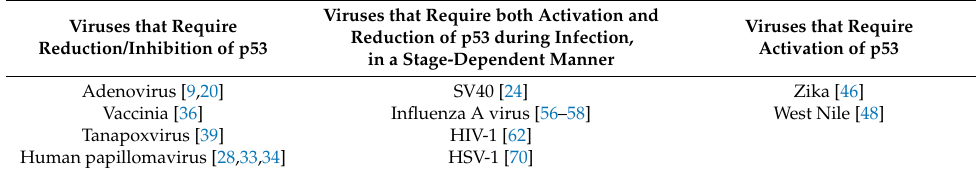
Table 2. Characterization of p53/virus